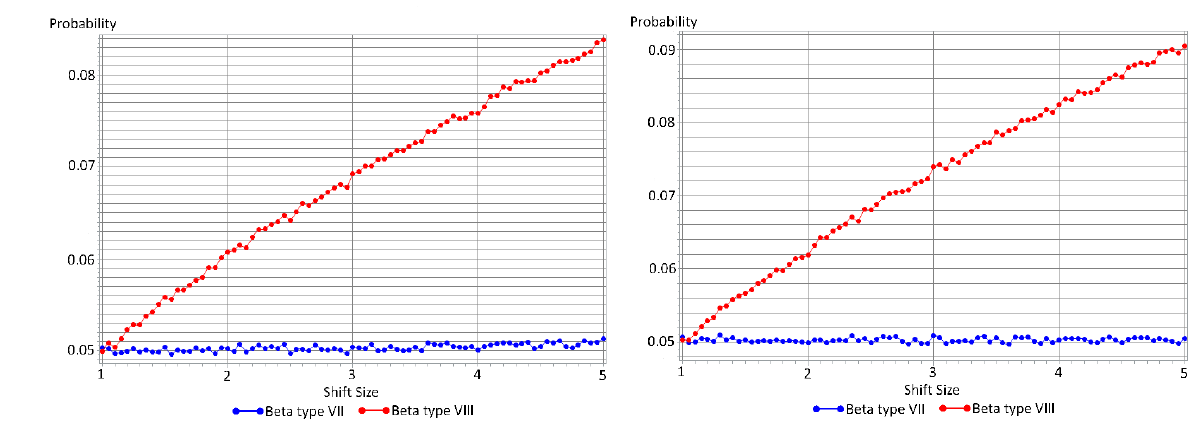
Figure 7. Probability of detecting a shift when n = 2.